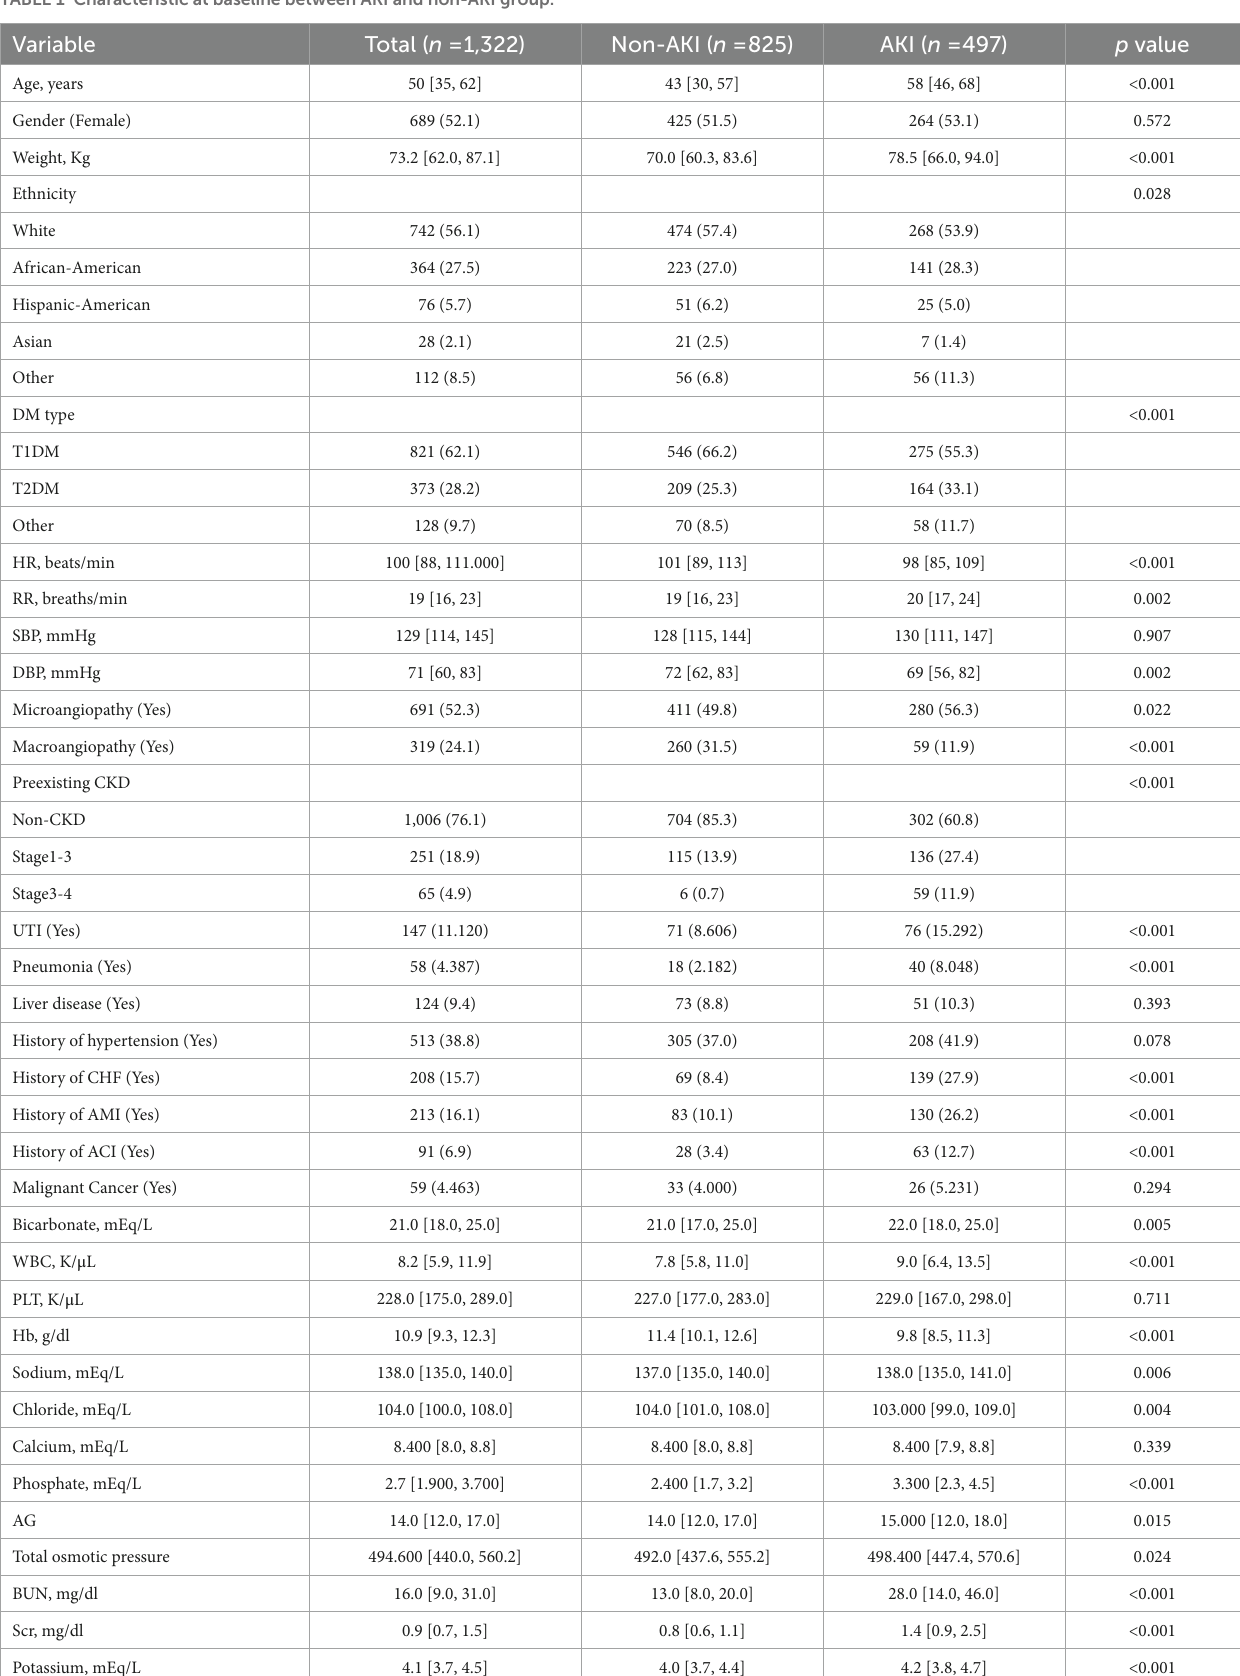
TABLE 1 Characteristic at baseline between AKI and non-AKI